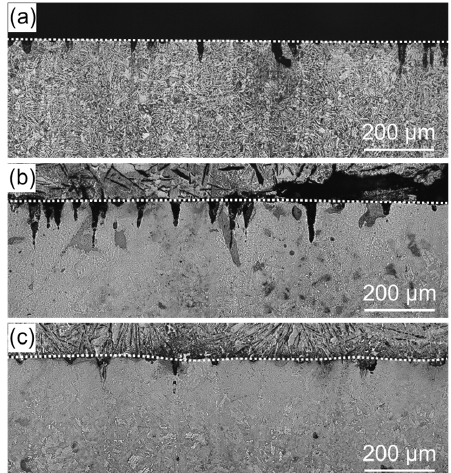
Figure 10. Enlarged cross-sectional OM images ( a ) as-received specimen and specimens treated with ( b ) WJP and ( c ) MFC for 2 min after the coating test. The dashed lines indicate the surface of each specimen.